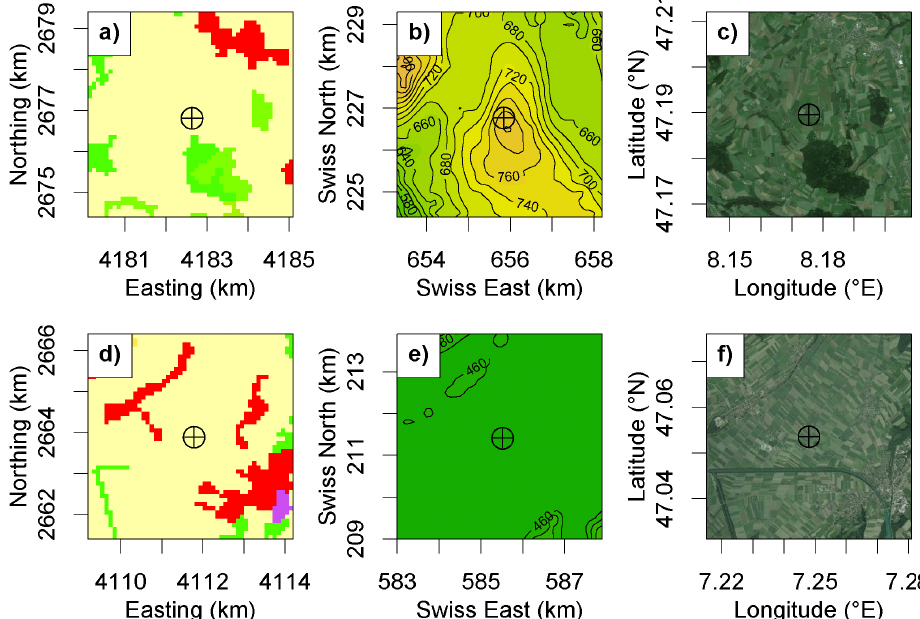
Figure 2. Site surroundings including land use (first column), topography (second column), and Google aerial photo (third column), with Beromünster (a – c) in the first row, and Gimmiz (d – f) in the second row. The land use (a and d) is based on CORINE 2006 land cover classes color coded as follows – urban: red; food croplands: beige; evergreen forest: green; deciduous forest: light green; pasture: light brown; agroforestry areas: tan. Cyan contour lines in the topography panels (b and e) denote the COSMO-2 model